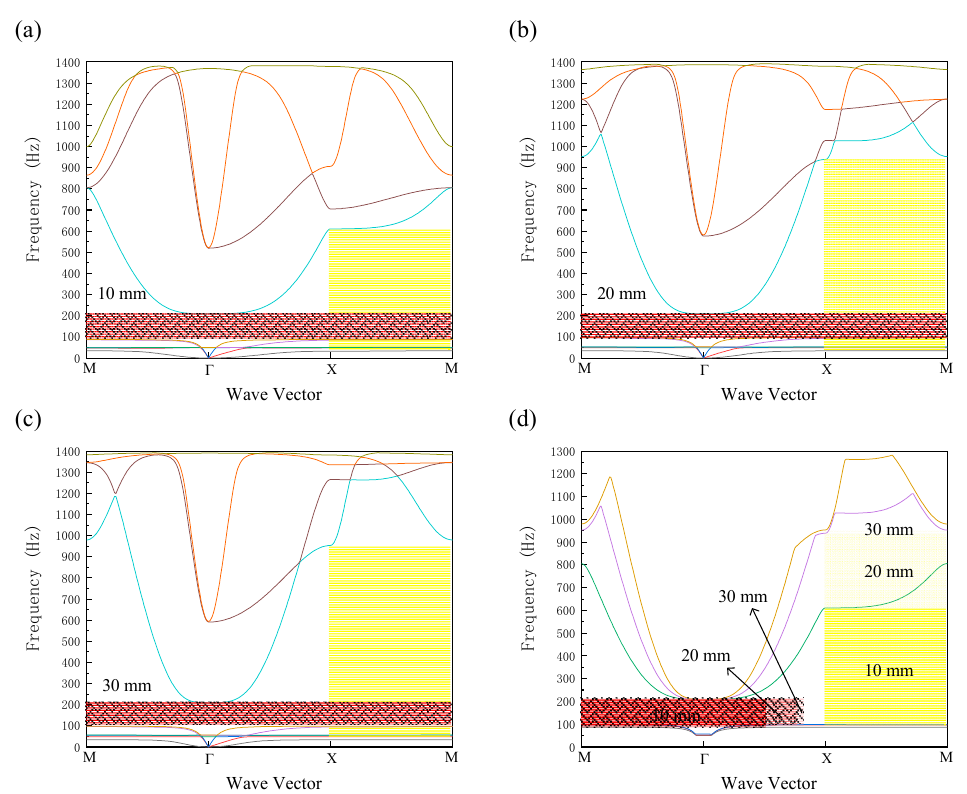
Figure 4. Band structure. The red area in the figure is the complete band gap, and the yellow area is the band gap in the X–M direction. Among them, the yellow and blue lines in ( a – c ) correspond to the sixth-order band and seventh-order band, respectively. The two-order bands are extracted and placed in ( d ) for comparison. ( a ) Band structure of 10 mm-thick phononic crystals plate. ( b ) Band structure of 20 mm-thick phononic crystals plate. ( c ) Band structure of 30 mm-thick phononic crystals plate. ( d ) Comparison analysis band diagram (sixth- to seventh-order band structure of phononic crystals plate with various